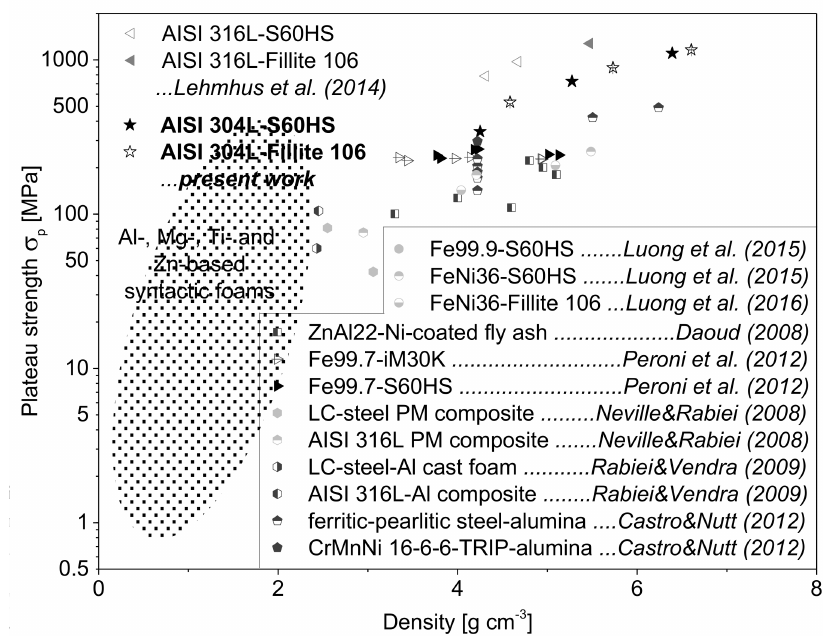
Figure 15. Comparison of the (mean) plateau strength and of different syntactic metallic foams under quasi-static loading, noticing that the AISI 316L- and the present AISI 304L-based foams exhibit the highest σ p -values for higher densities >4 g/cm 3 ; the ellipsoid strength region was extrapolated from